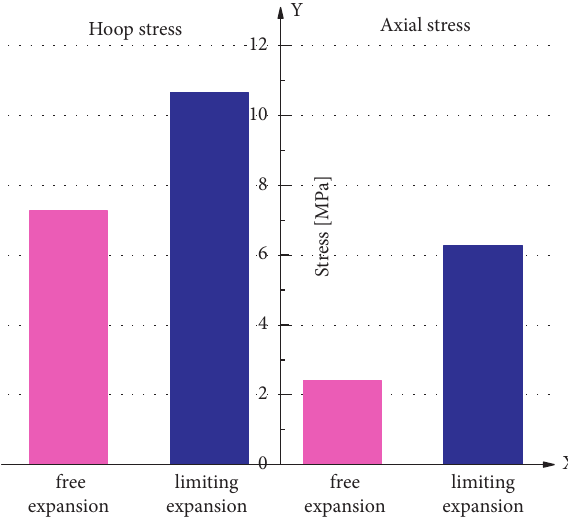
Figure 17: Stress of free expansion and limited expansion.